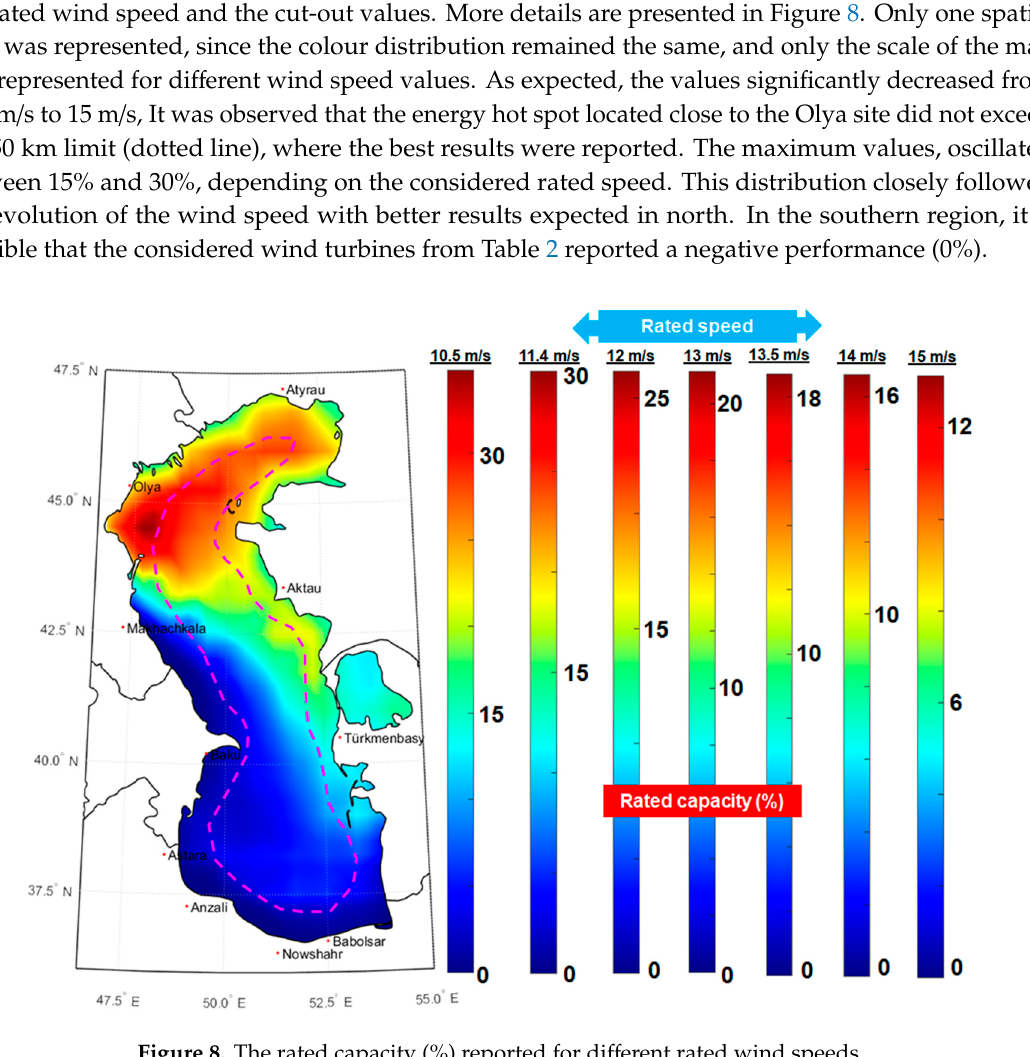
Figure 8. The rated capacity (%) reported for different rated wind speeds.